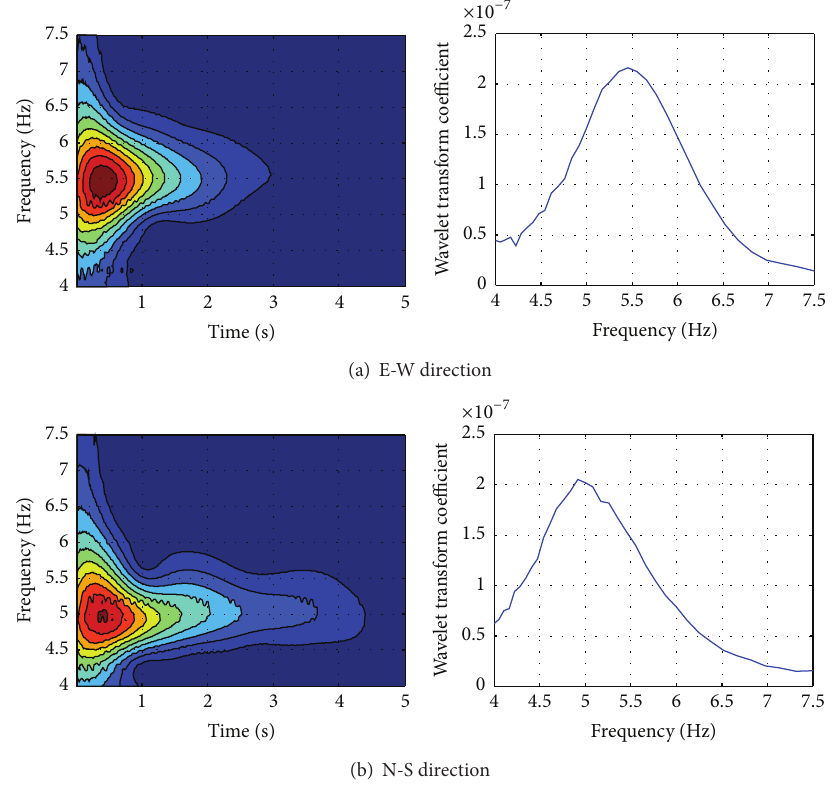
Figure 18: Time-frequency plot of RD signatures evaluated from displacement time histories at 3rd storey level in (a) the E-W and (b) N-S directions.